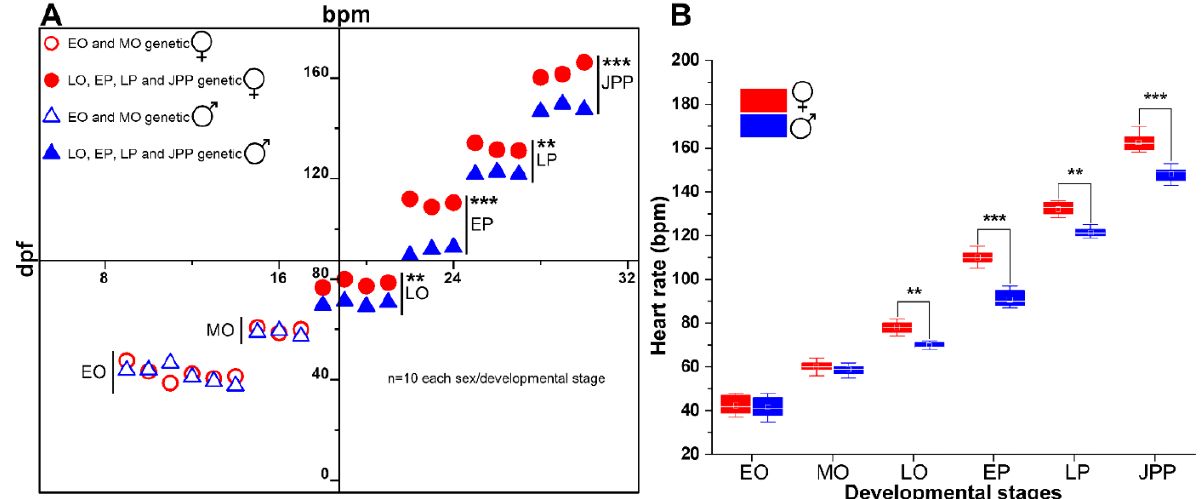
Figure 9. Graphs showing sex-specific differences in average heart rate with advancing embryonic stages of G. holbrooki . Both scatter ( A ) and box plots ( B ) show significant differences between HRs of males and females (n = 10/sex), except for EO and MO. ( A ) shows three different groupings of data, reflecting age (days post fertilisation; dpf), HR (bpm), and genetic sex of embryos. The onset of sex-specific differences in HR was at LO stage. All data are expressed as means ± SD. Values with asterisks are significant (** p < 0.01, *** p < 0.001). Small square and a horizontal line on each box plot indicate mean and median values, respectively.